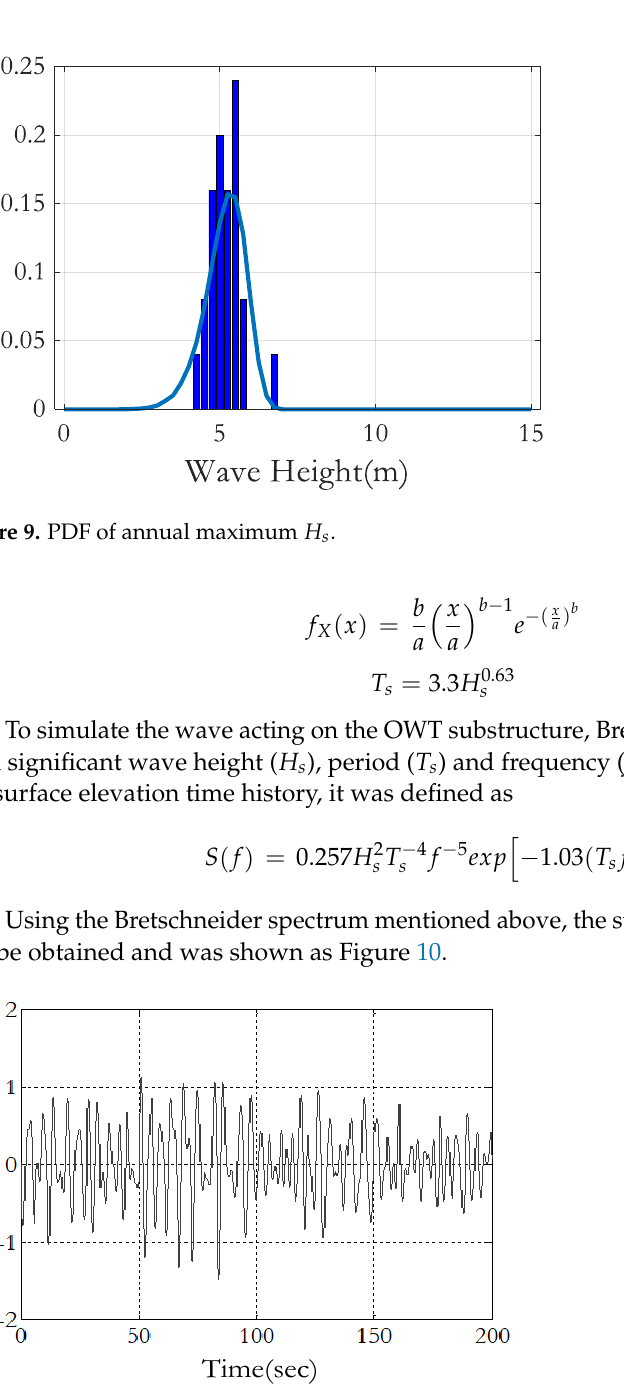
Figure 10. Surface wave elevation.